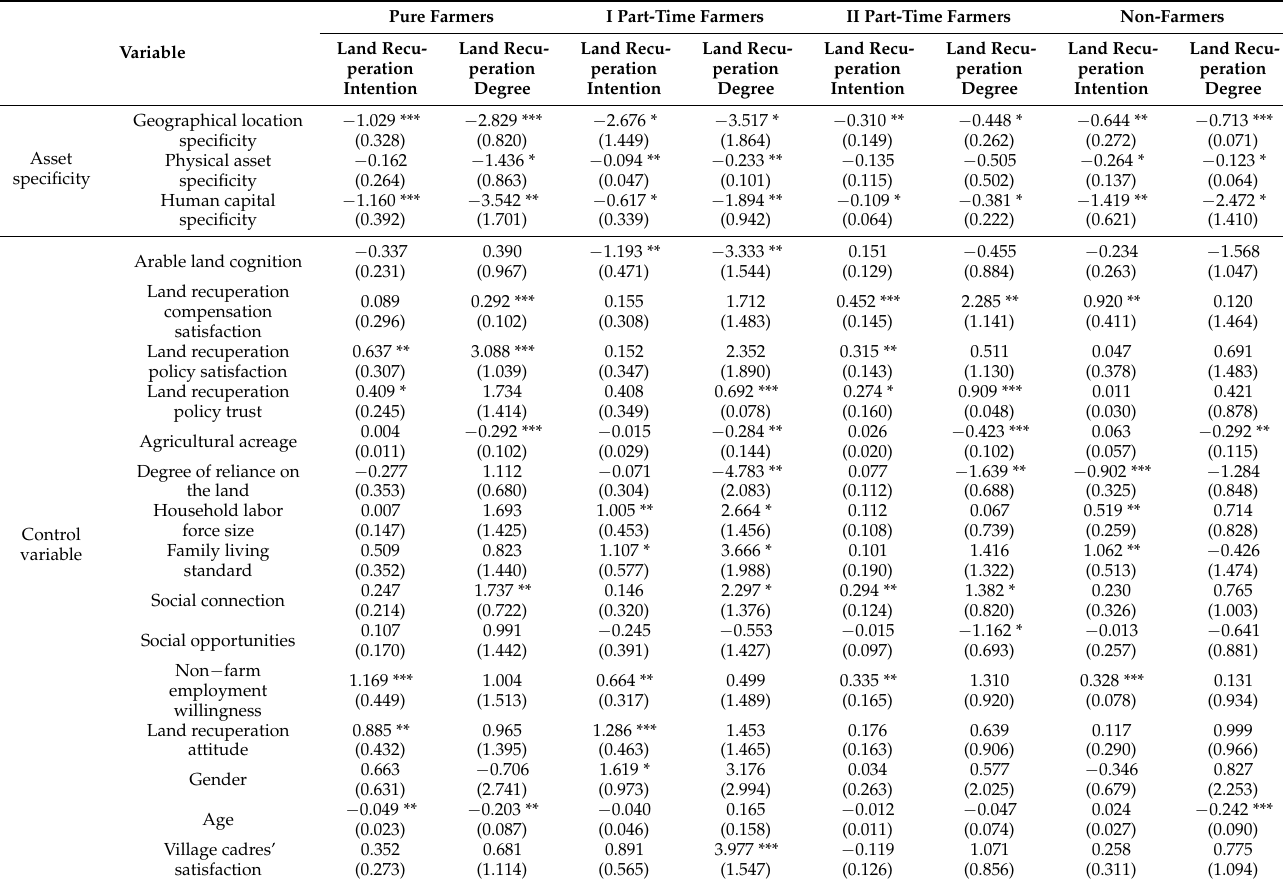
Table 7. Double-hurdle model regression